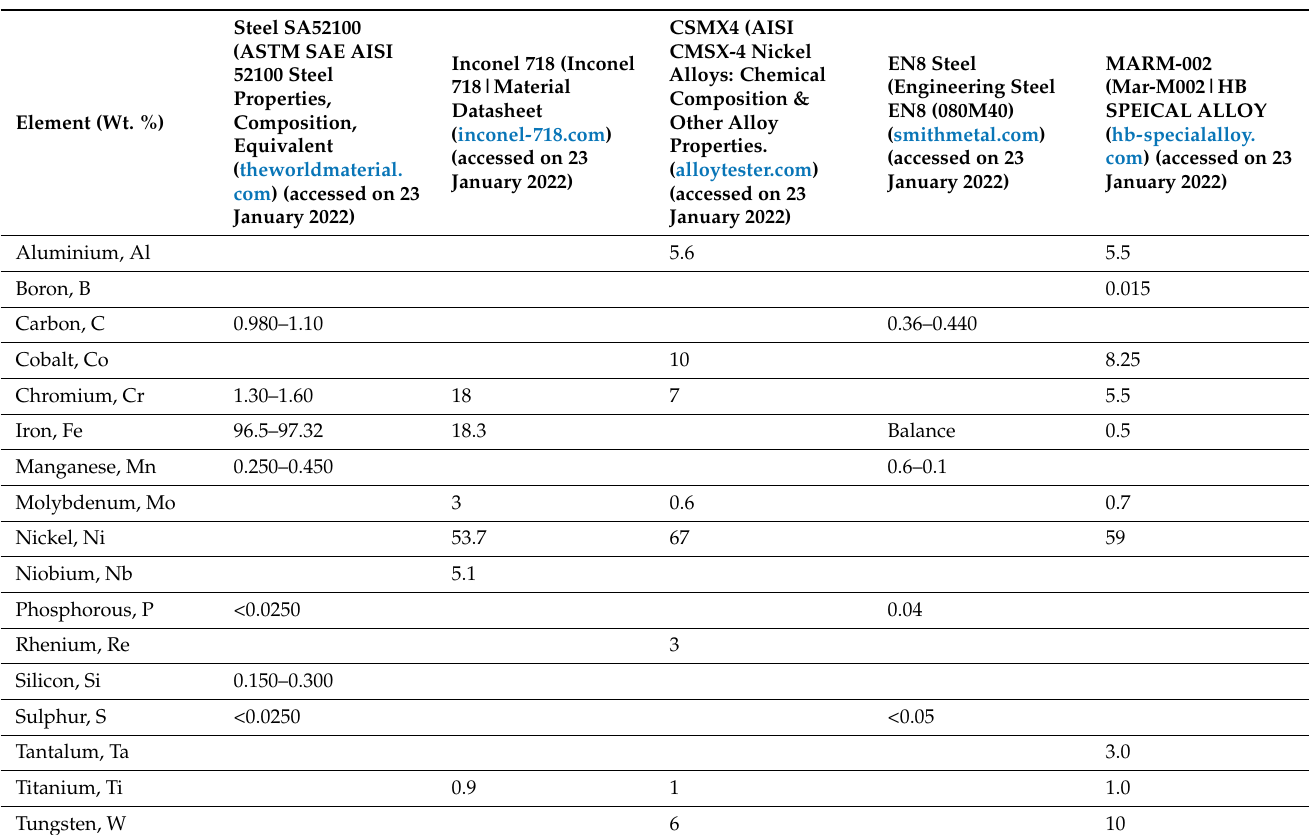
Table 2. Composition of materials used in this study.